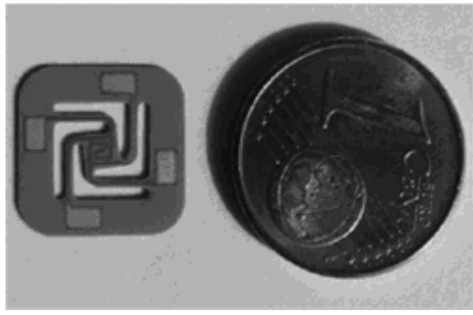
Figure 1. Gas sensor microheater fabricated using LTCC ceramics [2]. Hotplate size of about 2